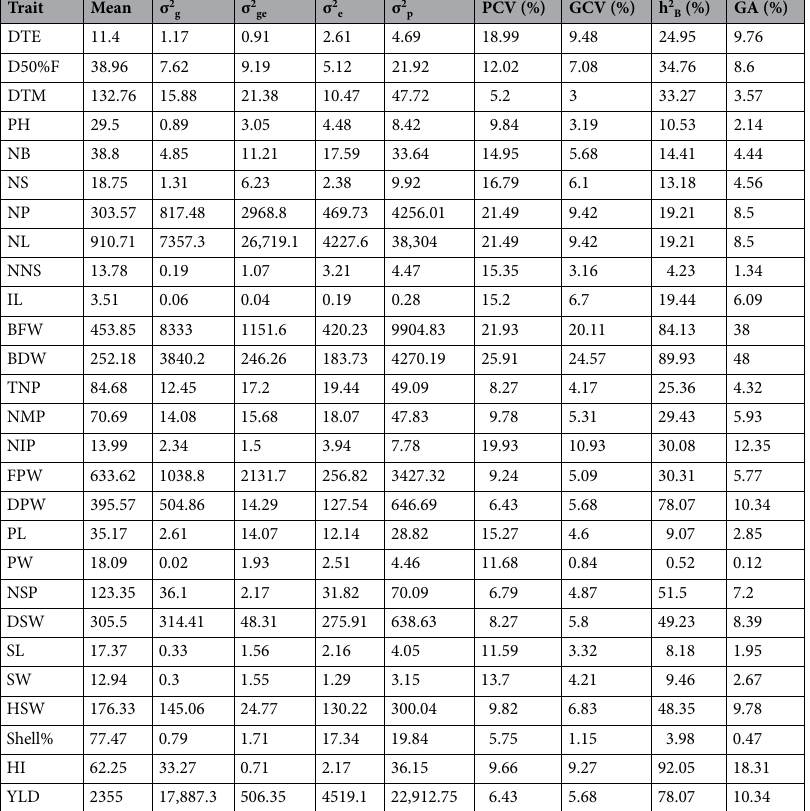
component analysis (PCA). In PCA variable loading, all the traits were positioned on the positive side excluding the traits D50%F, NIP, Shell%, and DTE. The angle between two vectors indicates the degree of association of the respective traits. The lower the angle higher the relationship between the trait and vice-versa. The angle of 90° between the trait indicated no association while more than 90° is suggested as a negative relationship. However, the density plot (Fig. 6C) showed the intensity of the genotypes’ dispersion based on yield potentials. Figure 6D illustrated the three-dimensional (3D) visualization of the 30 evaluated accessions.